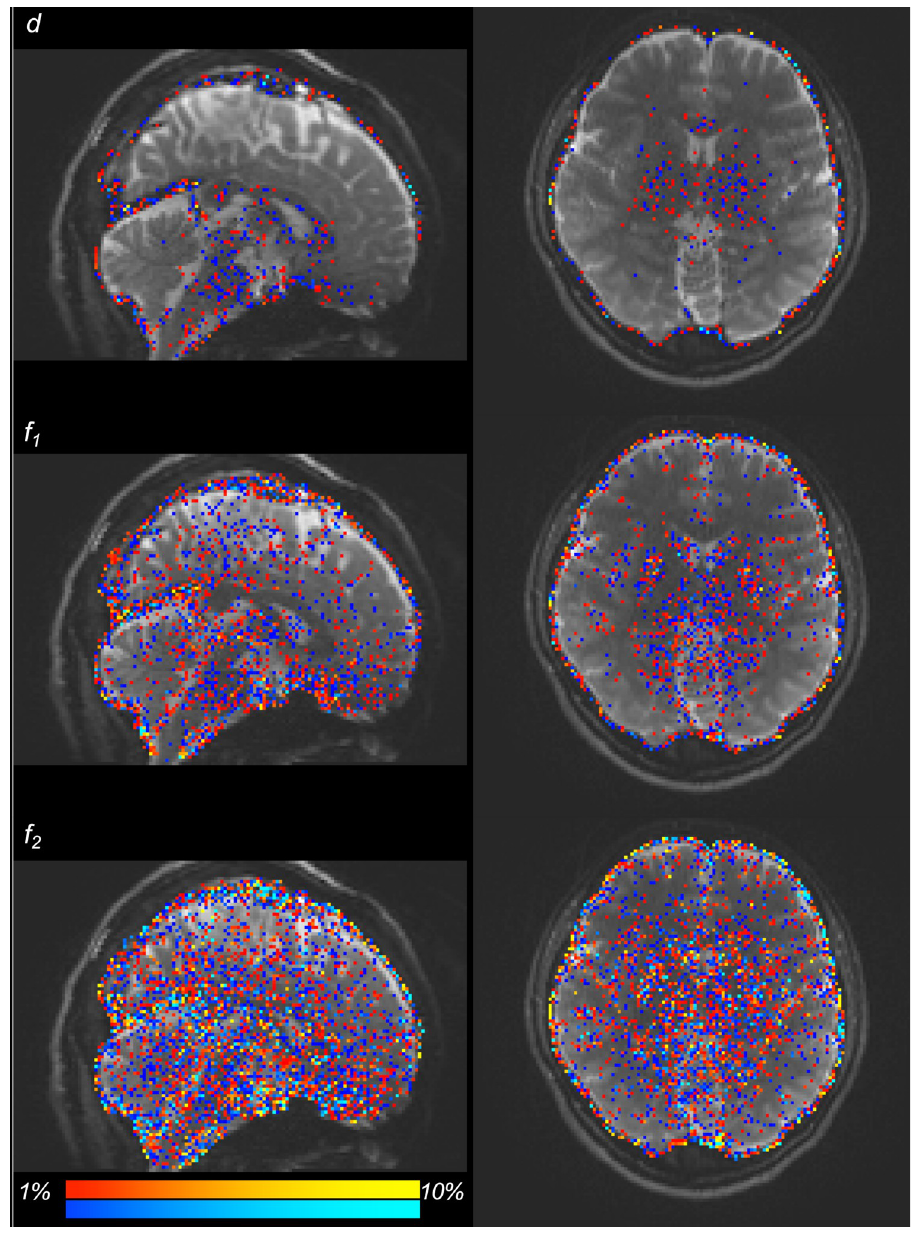
Fig 1. CPU and GPU L-M initialization difference map. L-M initialization difference between CPU and GPU. Orange-yellow colors are CPU > GPU regions, and blue-light blue colors are GPU > CPU regions. Difference in scalar maps are thresholded at a magnitude of 1% with respect to mean CPU